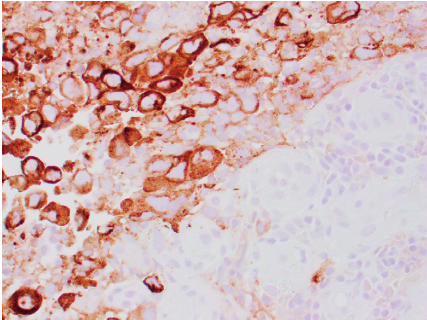
Figure 5: H&E staining of surgical specimen (Figure 4) with positive stain for HMB45 and Melan-A, suggesting diagnosis of